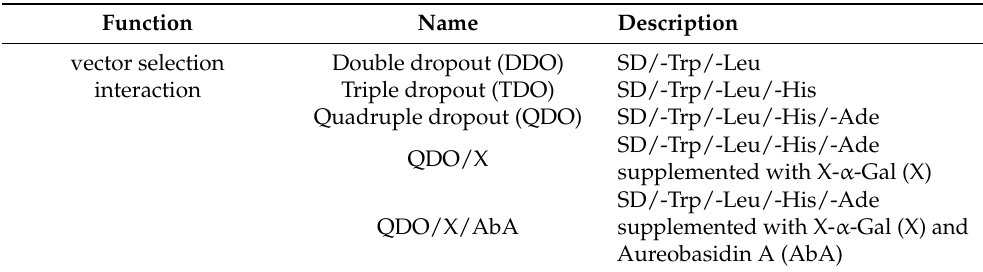
Table 1. Media used for the yeast two-hybrid assay.